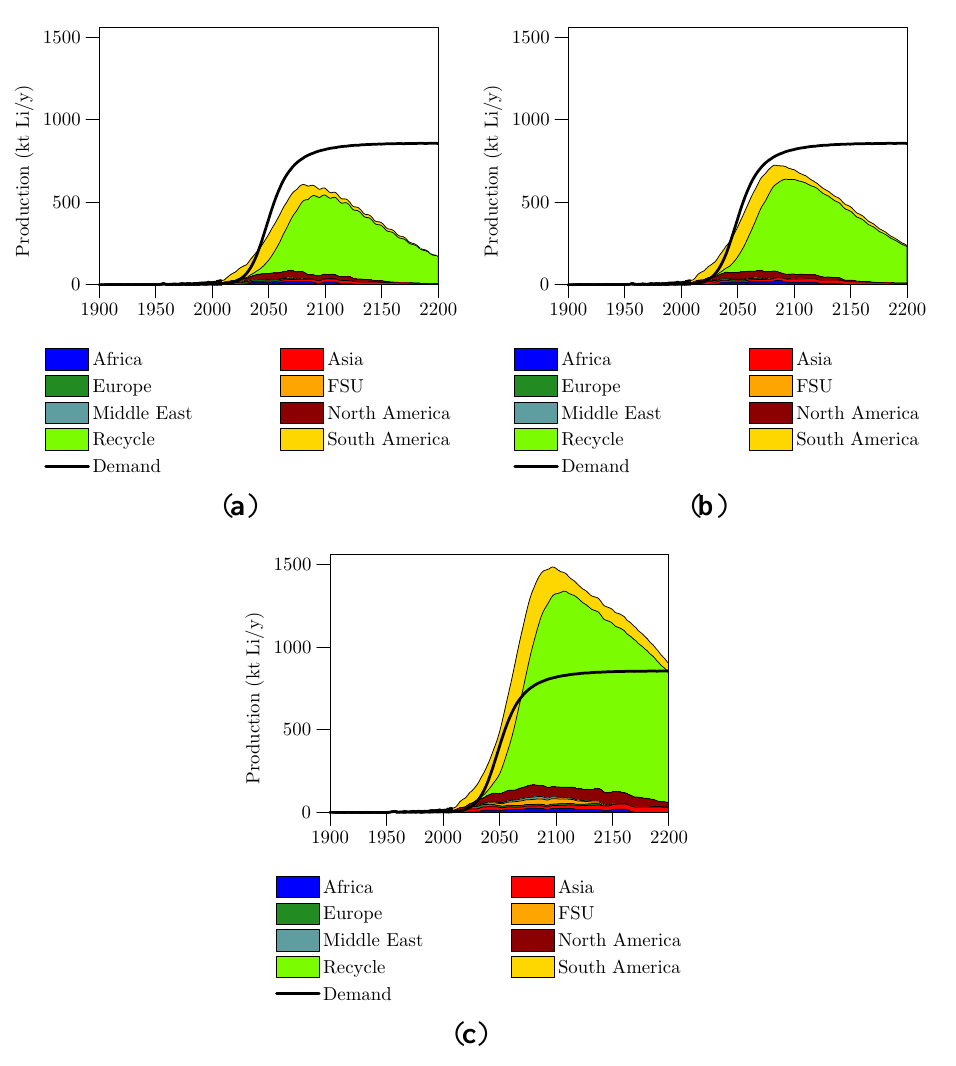
Figure 3. Projected lithium supply and demand by continent. ( a ) Case 1; ( b ) Case